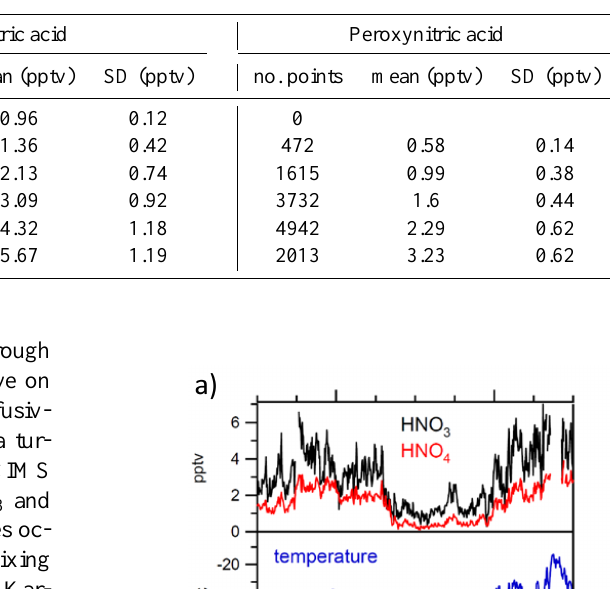
Table 1. Mean and standard deviation of nitric acid and peroxynitric acid according to ambient air temperature range. The statistics were derived using only data above the 3 σ detection limit.